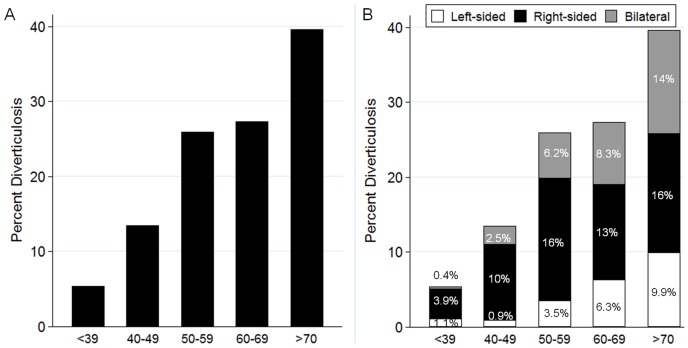
Prevalence of diverticulosis (A) and anatomic distribution (B) by age category (n = 2,164).Colonic diverticulosis increased with age (A). The prevalence of right-sided diverticula was high at for younger age, while left-sided and bilateral types increased with age (B).